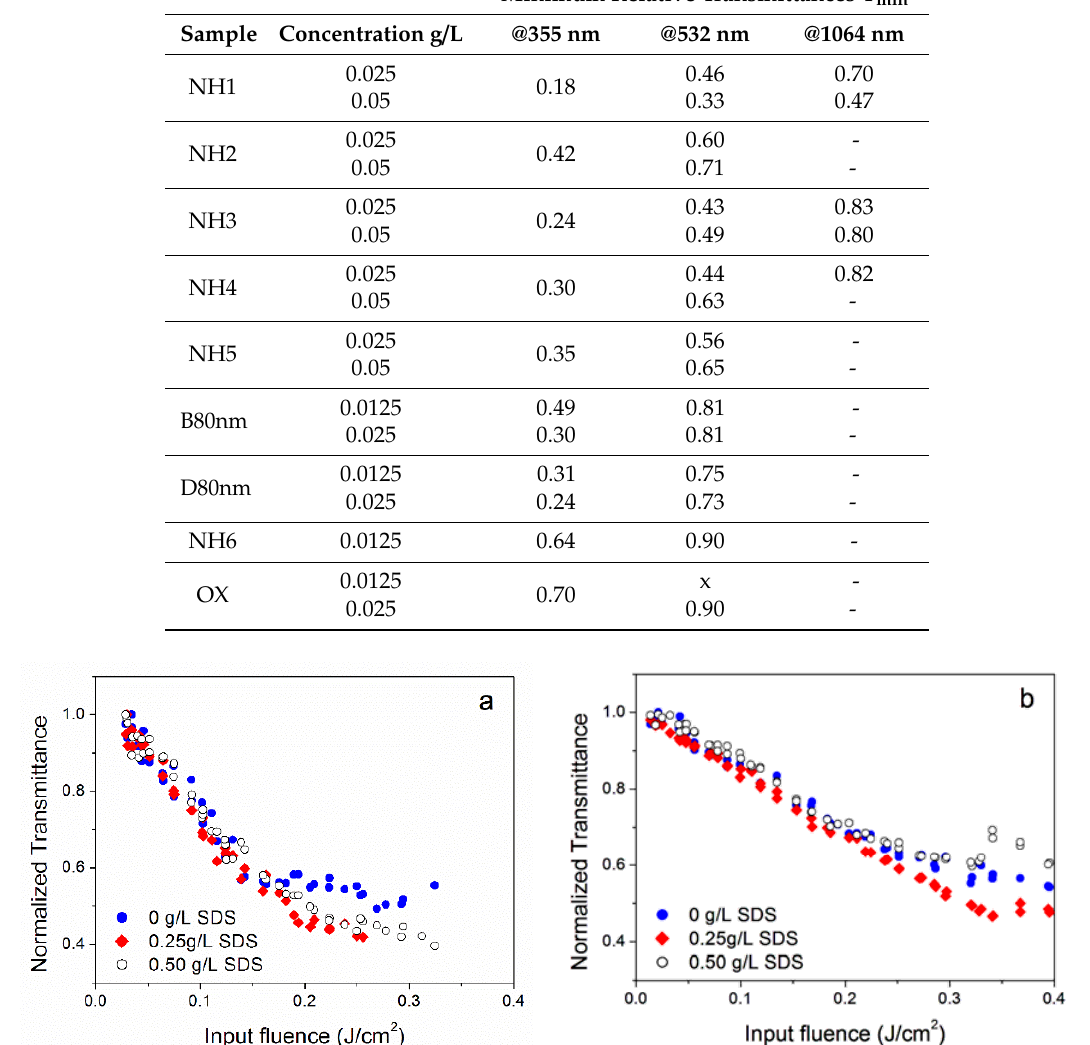
Figure 4. Effect of the surfactant concentration on the optical limiting properties of the NH6 sample at 355 ( a ) and at 532 nm ( b ).